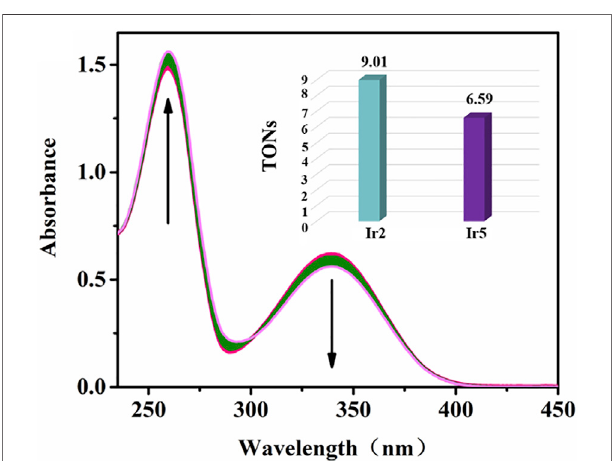
FIGURE 9 | Reaction of Ir2 (1 μ M) and NADH (100 μ M) in 10% MeOH/ 90% H 2 O (v/v) solution detected by UV-vis spectra over 8 h. The arrow show the change of intensity over time; Inset: TONs of Ir2 and